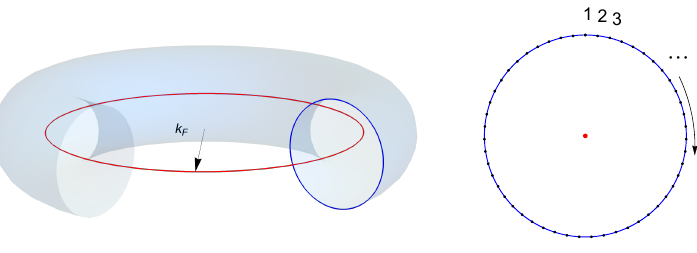
Figure 7 . Left: the illustration of the closed path (blue curve) that encloses a Weyl node along the nodal line (red curve). Right: a series of discrete black points are selected along the closed path.